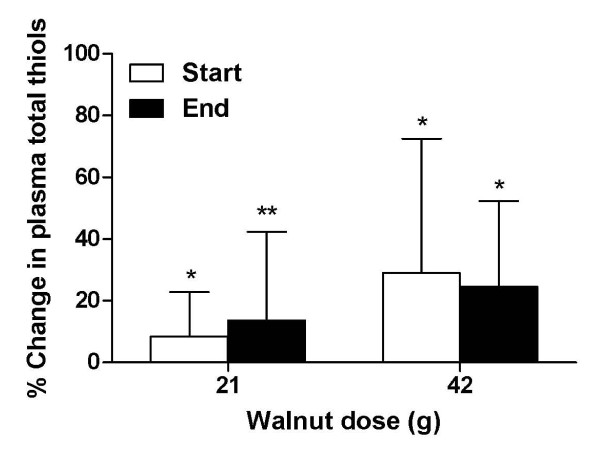
Acute changes in plasma total thiols within 1 h of walnut consumption. Mean total plasma thiols just prior to consuming a single 21 g dose were 2.90 ± 0.52 and 2.81 ± 0.41 mM, respectively, during the start and end of intervention visits for this phase. Mean total plasma thiols just prior to a single 42 g dose were 2.65 ± 0.63 and 2.55 ± 0.38 mM during the start and end visits for this phase. Changes in plasma total thiols were measured 1 h following walnut consumption, and compared with the respective baseline values at each visit using paired t-tests. P > 0.05 for between group differences, * P < 0.05 for change from baseline values, **P = 0.058 for change from baseline.